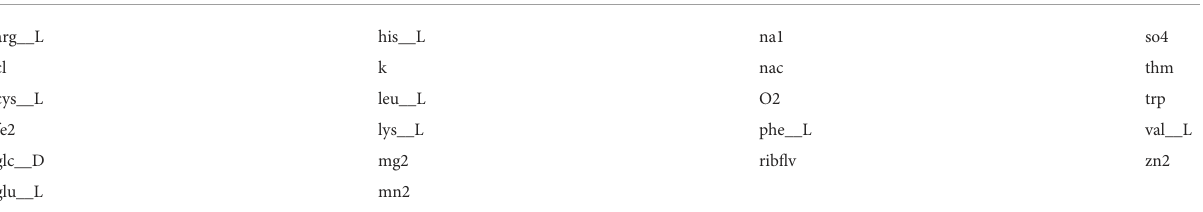
TABLE 1 Common uptake metabolites between D. pigrum and S. aureus with the relevant descriptive name extracted from the BiGG Models Database (Norsigian et al., 2020). Common uptake metabolites